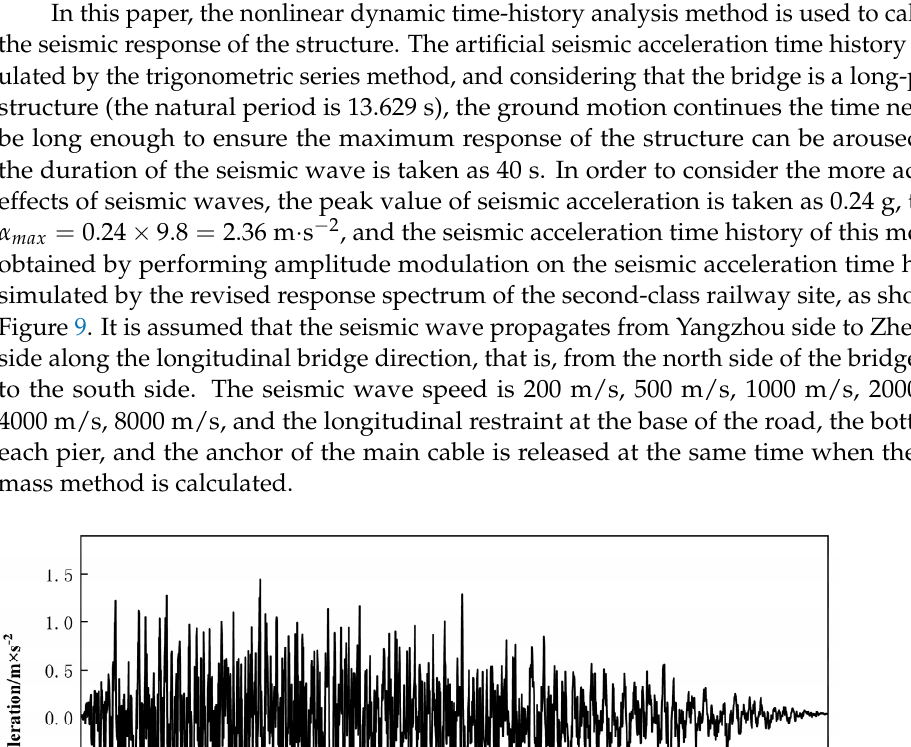
Figure 8. Corrected response spectrum for railway Class II Sites.